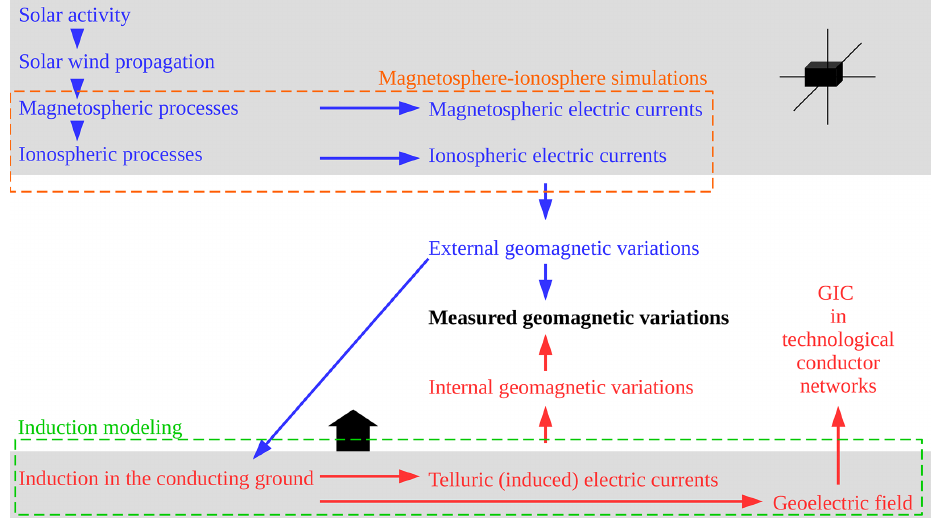
Figure 1. Principle of geomagnetic variations and geomagnetically induced currents (GICs): disturbances created by solar activity propagate to the Earth and interact with the Earth’s magnetosphere–ionosphere system, creating electric currents in the near-Earth space. The spatially and temporally highly varying “external” magnetic field of these currents drives induction in the conducting ground. The “internal” magnetic field of the induced telluric electric currents is superposed to the external magnetic field, producing geomagnetic variations that can be measured by magnetometers on the ground or at low-orbit satellites. The relative contribution of internal and external magnetic fields depends on the distance of the measurement point to the various current systems, such that the internal contribution is the strongest on the ground and weakens with increasing altitude. The induced geoelectric field drives GICs in technological conductor systems. Global magnetosphere–ionosphere simulations can typically describe the external part of geomagnetic variations only, while induction modeling is needed for describing the electromagnetic interaction between the conducting Earth and external geomagnetic